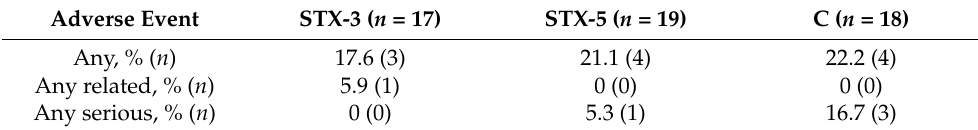
Table 2. Frequency of adverse events during the follow-up, by study arm.